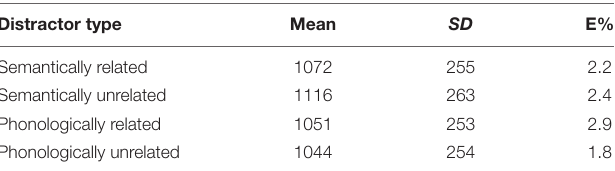
TABLE 1 | Average naming latencies (Mean), standard deviations (SD) in ms, and error rates (E%) by condition for Experiment 1. Distractor